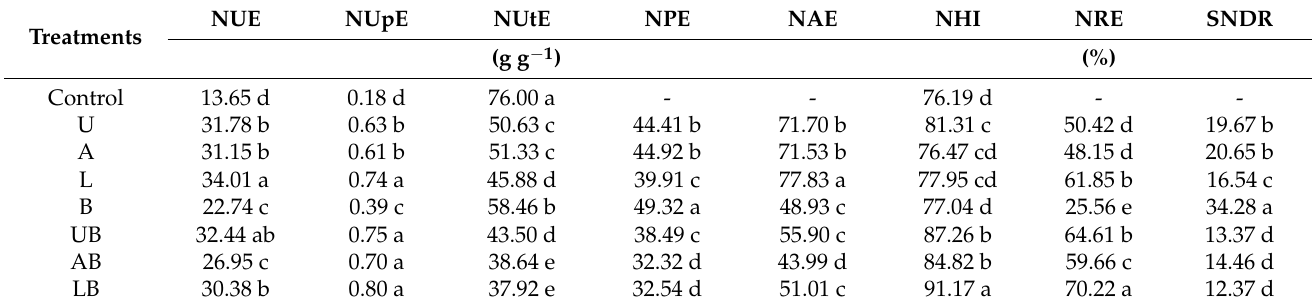
Table 4. Changes in nitrogen indices in different